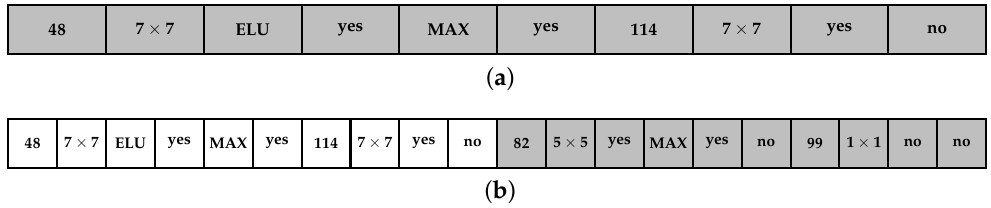
Figure 6. Building deeper CNNs by concatenating solutions from performed phases. ( a ) An example of solution for P 0 encoding the phase 0 CNN of Figure 5 (left), ( b ) Solutions at P 0 and P 1 encoding the phase 1 CNN of Figure 5